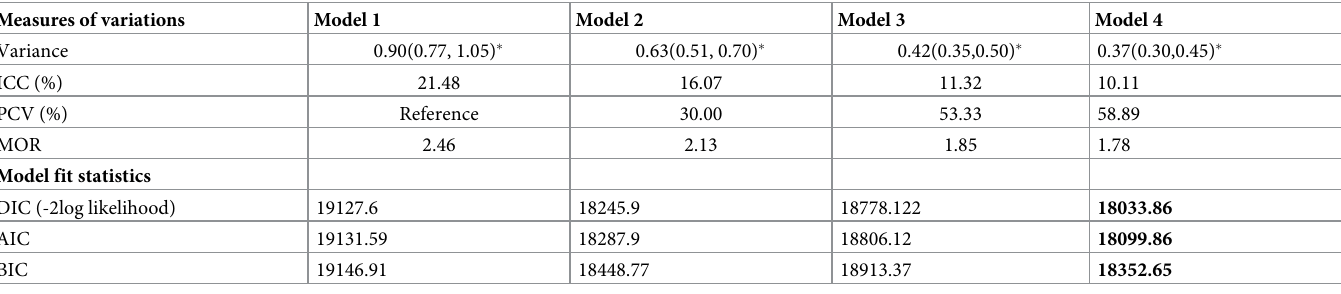
Table 3. Measures of variation and model fit statistics on women unemployment in